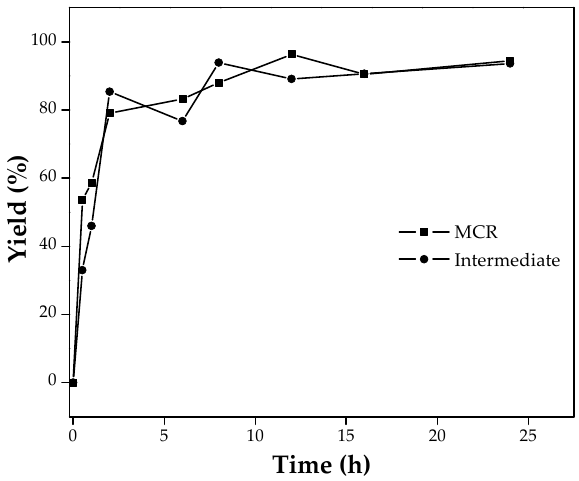
Figure 8. 4 H -pyran synthesis via MCR and Michael addition with LDH–Ni.